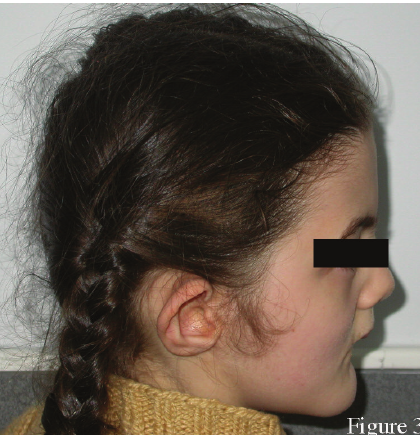
Figure 3: Lateral view of the patient. Note the retrognathic man- dible.